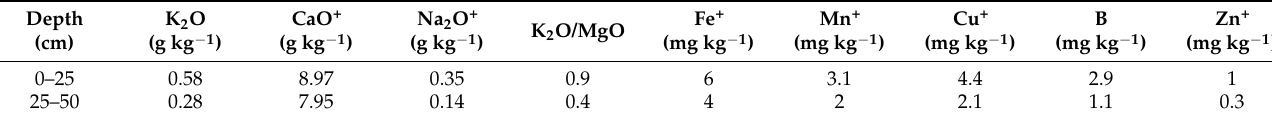
Table 1. Soil chemical composition in the studied orchards.